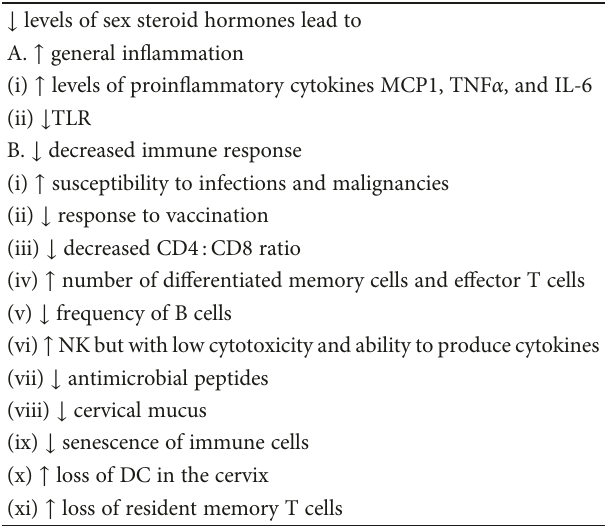
Table 1: Immune pro fi le of the cervix during menopause. ↓ levels of sex steroid hormones lead